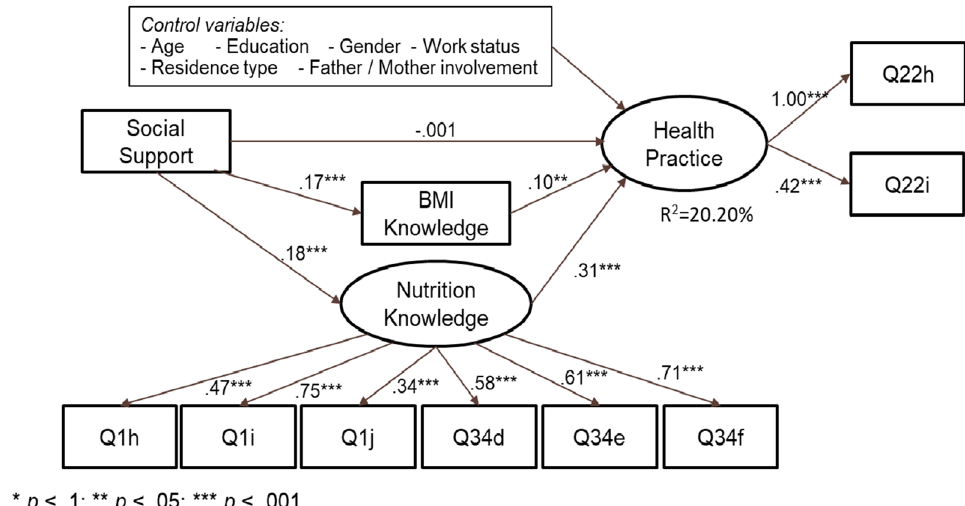
Fig. 3 SEM model 1 testing the mediating effects of health knowledge on the relationship between social support and children’s health practice. Parameters of control variables are not presented in this graph due to parsimony